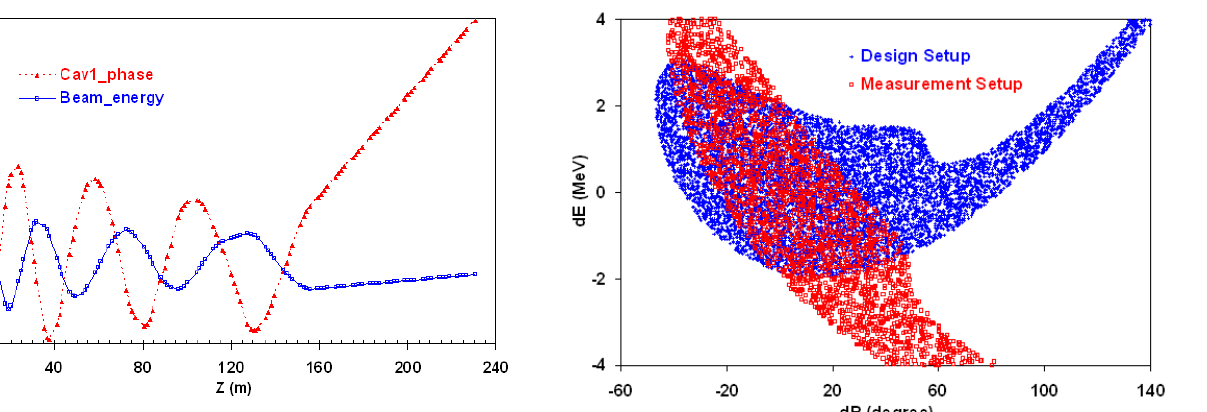
FIG. 3. (Color) Model longitudinal acceptance of the first cavity at the design phase (cid:1) 15 (cid:3) (Design setup) and at the measurement phase (cid:1) 90 (cid:3) (Measurement setup).